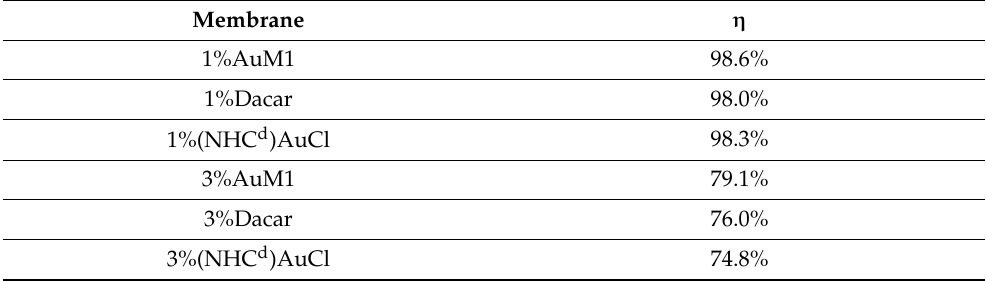
Table 1. Roughness parameters evaluated for the various membranes. Table 2. Encapsulation efficiency of the